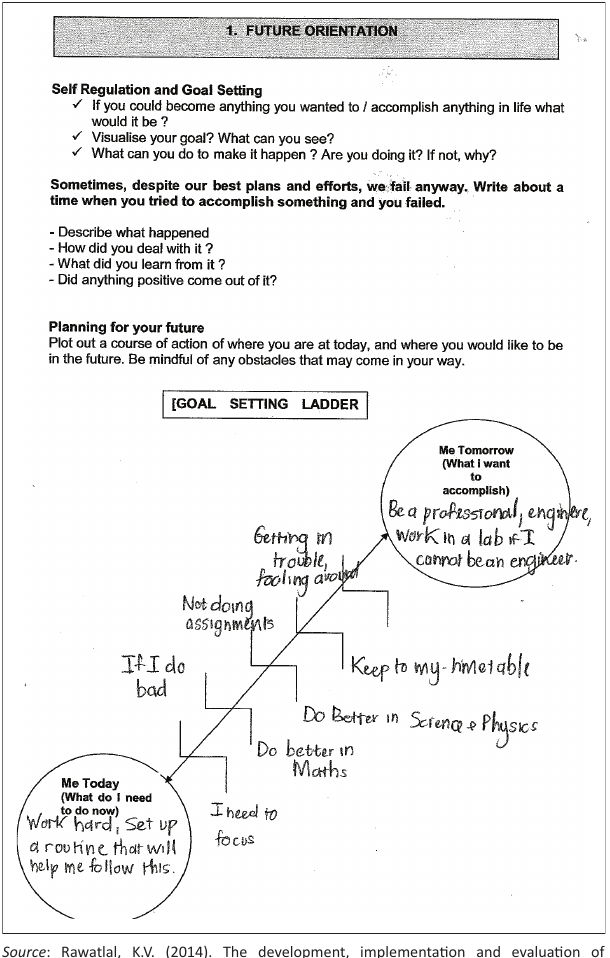
FIGURE 2: Excerpt of learner applying himself to the future orientation and goal- setting